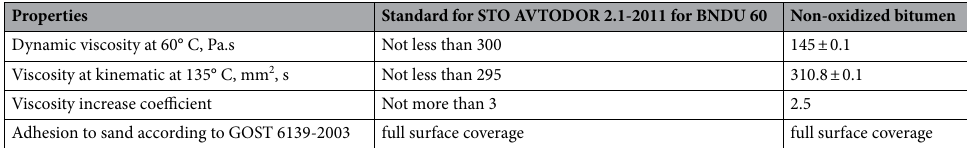
Table 6. Rheological measurements and results of the interactions between stone and asphalt of oxidized bitumen.